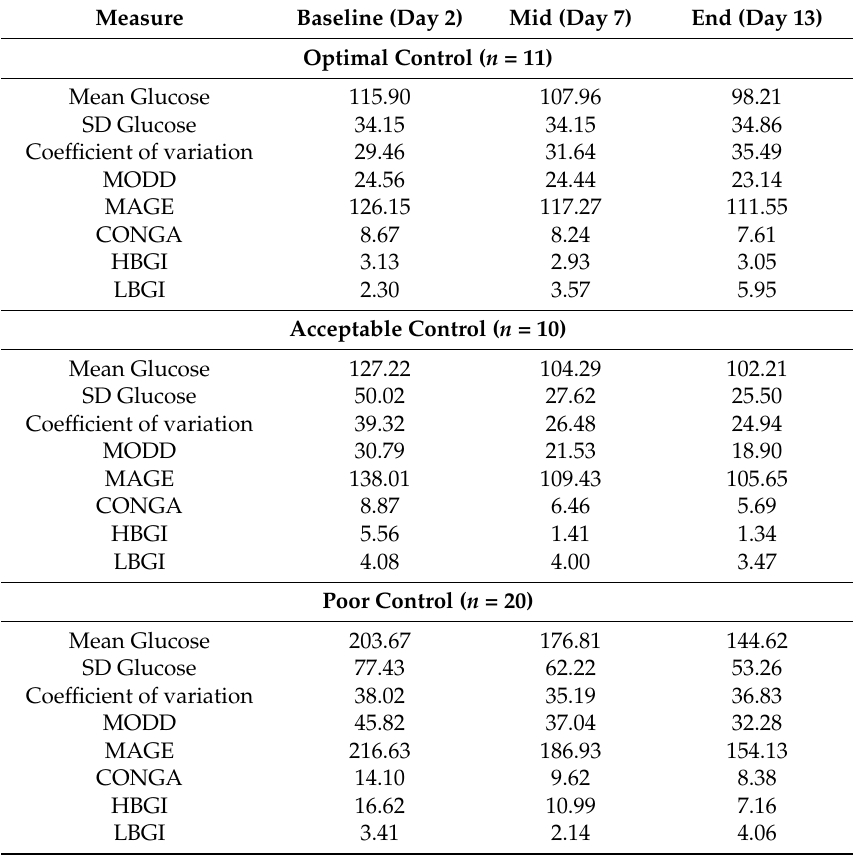
Table 4. Change in mean blood glucose and glycemic variability